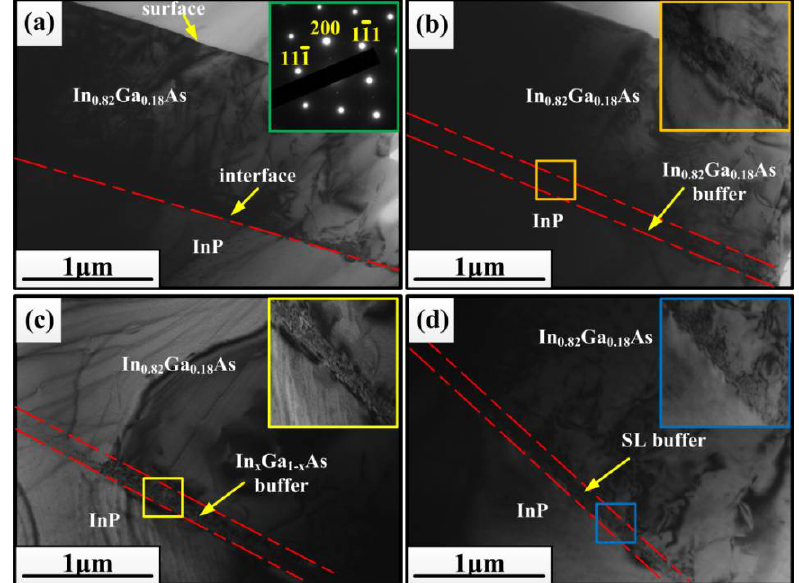
Figure 5. The transmission electron microscopy (TEM) images of In 0.82 Ga 0.18 As epitaxial layer grown on InP (100) substrates: ( a ) sample A without buffer layer; ( b ) sample B with In 0.82 Ga 0.18 As buffer